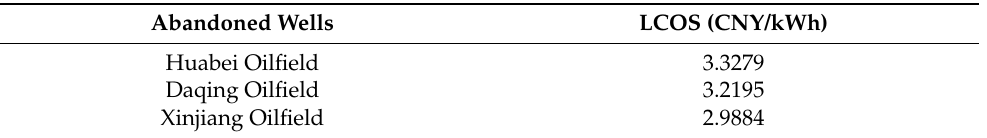
Table 11. LCOS values of the gravity energy storage system by virtue of abandoned oil wells in the three major oilfields with annual cycle times of